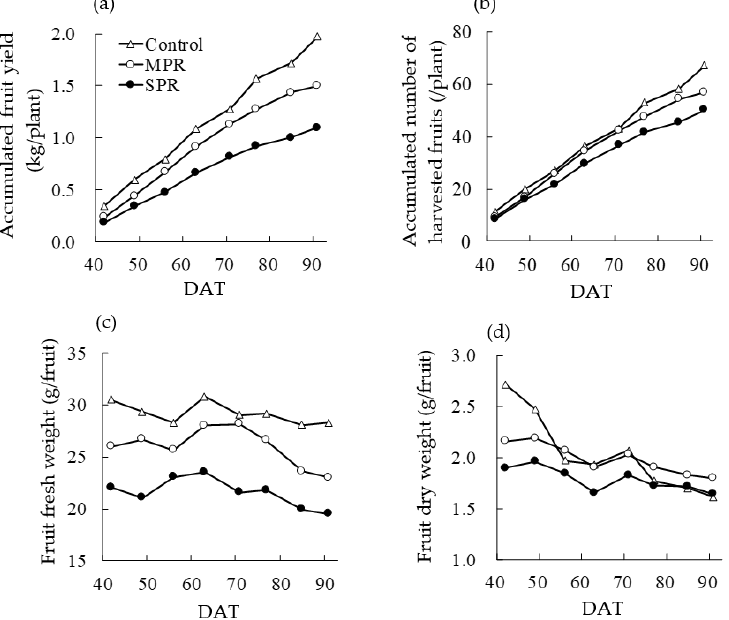
Figure 4. Effects of water stress on the accumulated fruit yield ( a ), accumulated number of harvested fruits ( b ), fruit fresh weight ( c ), and fruit dry weight ( d ) of tomatoes. Throughout the experiment,